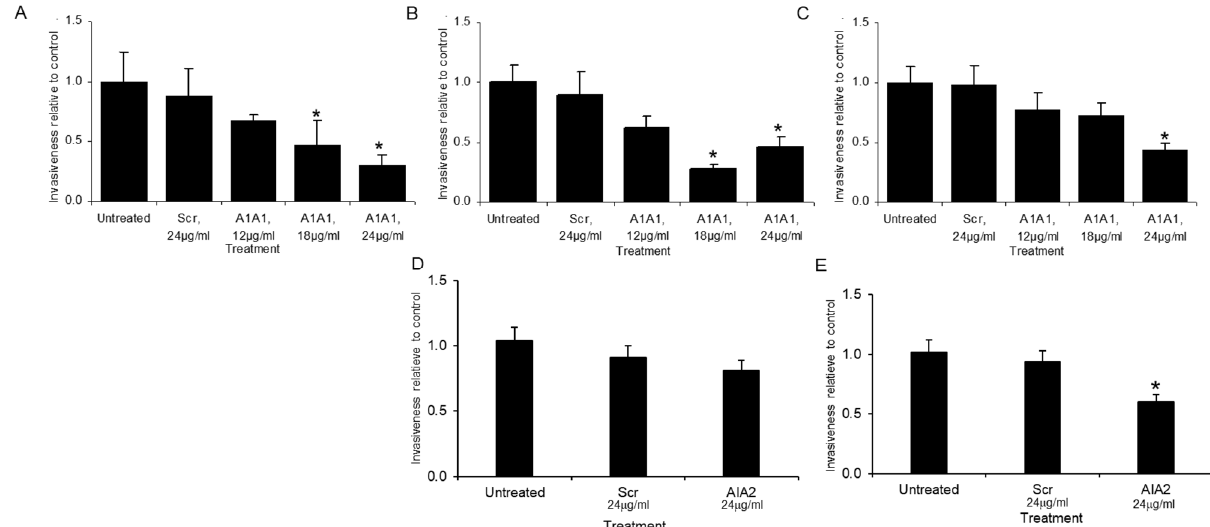
Figure 4. Invasiveness of cancer cell lines after incubation with anti-invasive aptamers or control aptamer (Scr). ( A – C ) Cells were incubated untreated or with either 24 µ g/mL control scrambled aptamer (Scr) or three concentrations of AIA1 at 12, 18, and 24 µ g/mL and the proportion of cells passing through a membrane relative to untreated cells was determined. ( A ) PC-3 Luc 5-Inv cells. ( B ) C4-2B prostate cancer cells. ( C ) 82L osteosarcoma cells. ( D , E ) Cells were incubated untreated or with either 24 µ g/mL control scrambled aptamer (Scr) or AIA2 at 24 µ g/mL and the proportion of cells passing through the membrane relative to the untreated cells was determined. ( D ) PC-3 Luc 5-Inv cells. ( E ) C4-2B prostate cancer cells. Results are reported as mean ± SD of three individual experiments. * p < 0.05 versus scrambled control.